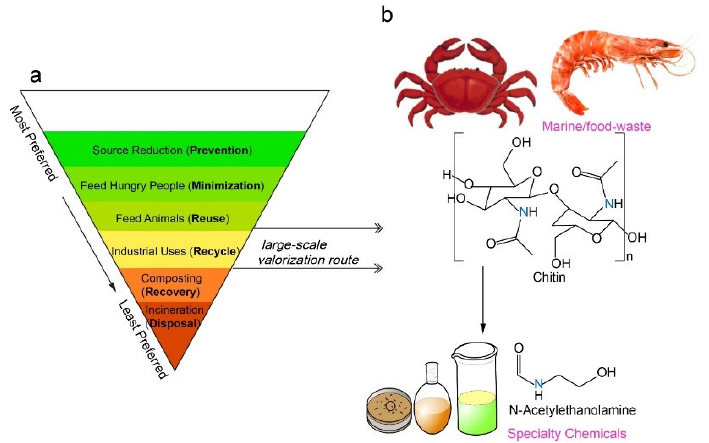
Figure 1. The big picture: ( a ) Environmental Protection Agency (EPA)’s proposed hierarchical pyramid model on dealing with food waste. To minimize bio-waste, large-scale industrial valorization to valuable chemicals is highly recommended. ( b ) In this work, we demonstrate inexpensive Ni/CeO 2 -based catalyst-mediated transformation from chitin to N -acylethanolamine, a water-soluble secondary organic amine compound with high industrial and pharmaceutical relevance. Therefore, chitin could be considered as a renewable feedstock for producing organonitrogen compounds in the specialty chemical industry.